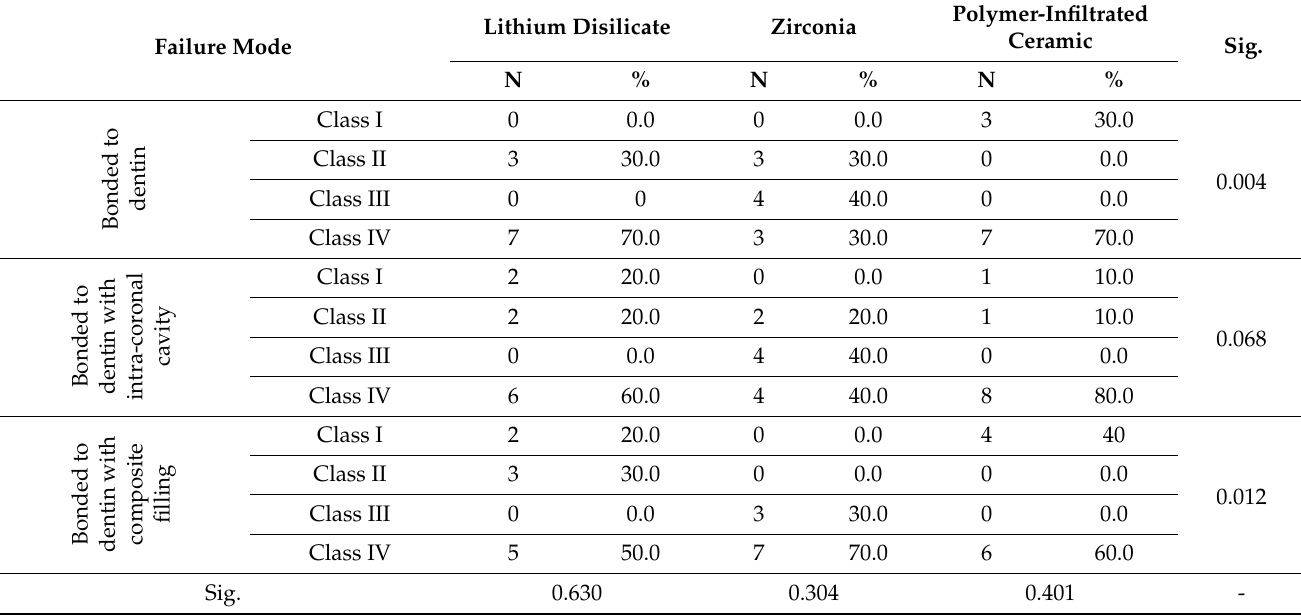
Table 5. Failure mode percentage (%) among study